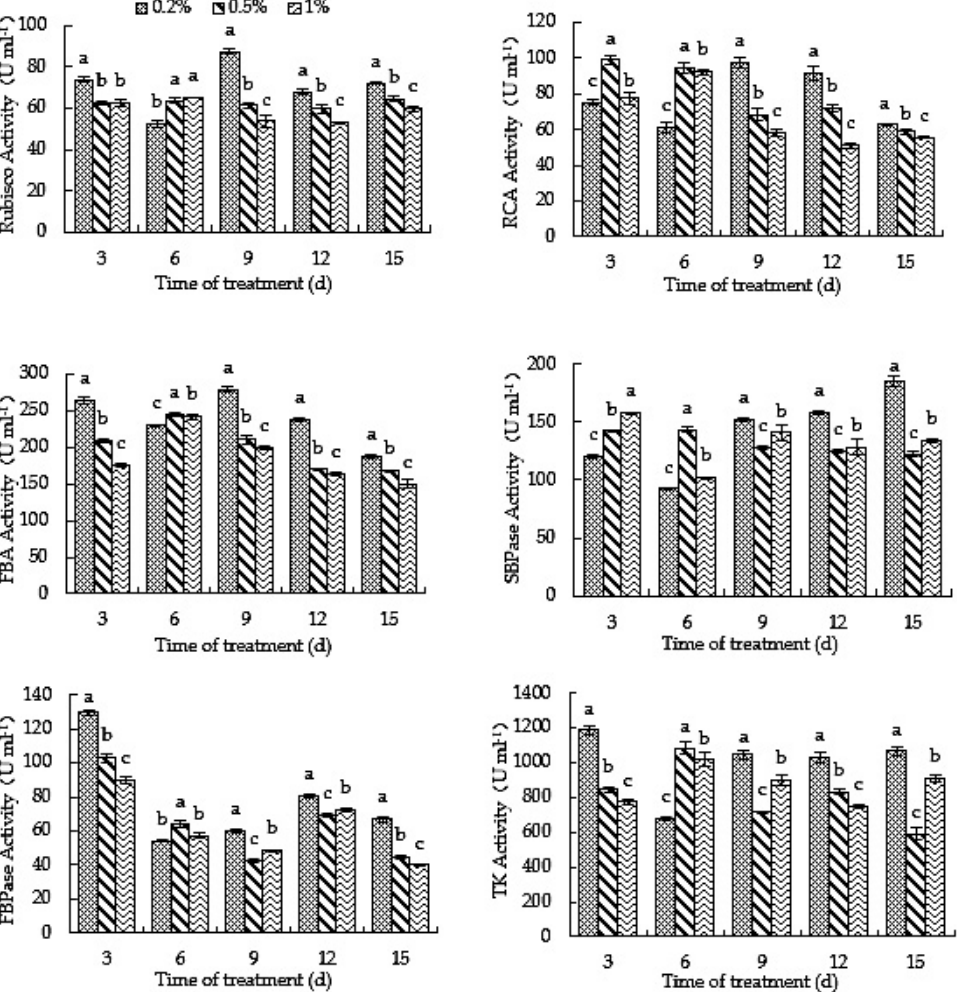
Figure 8. High root-zone CO 2 affects the activities of carbon assimilation-related enzymes in oriental melon. Standard errors (SEs) of the means are represented by error bars. Different letters in the same row indicate significance at the 0.05 level among treatments.